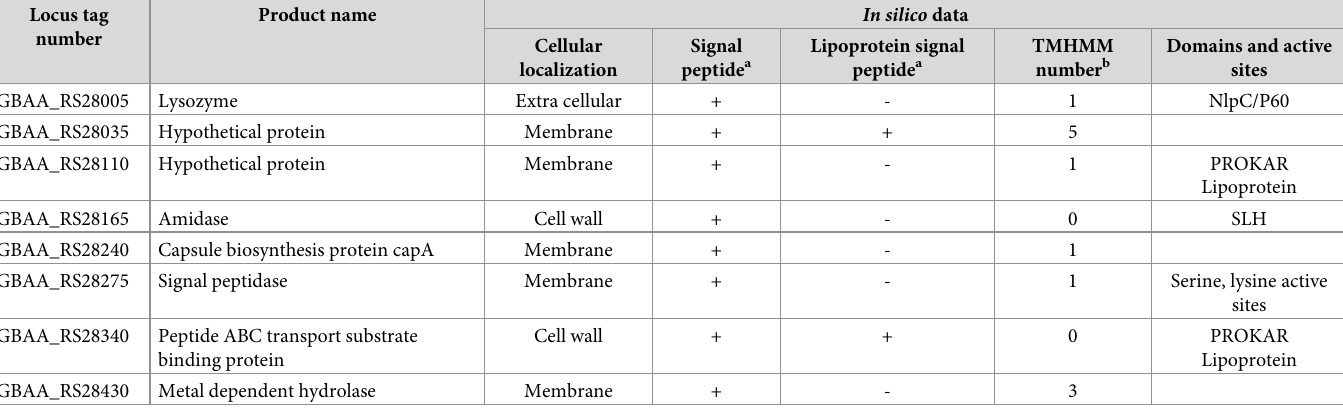
Table 2. In silico selected CDSs for identification of